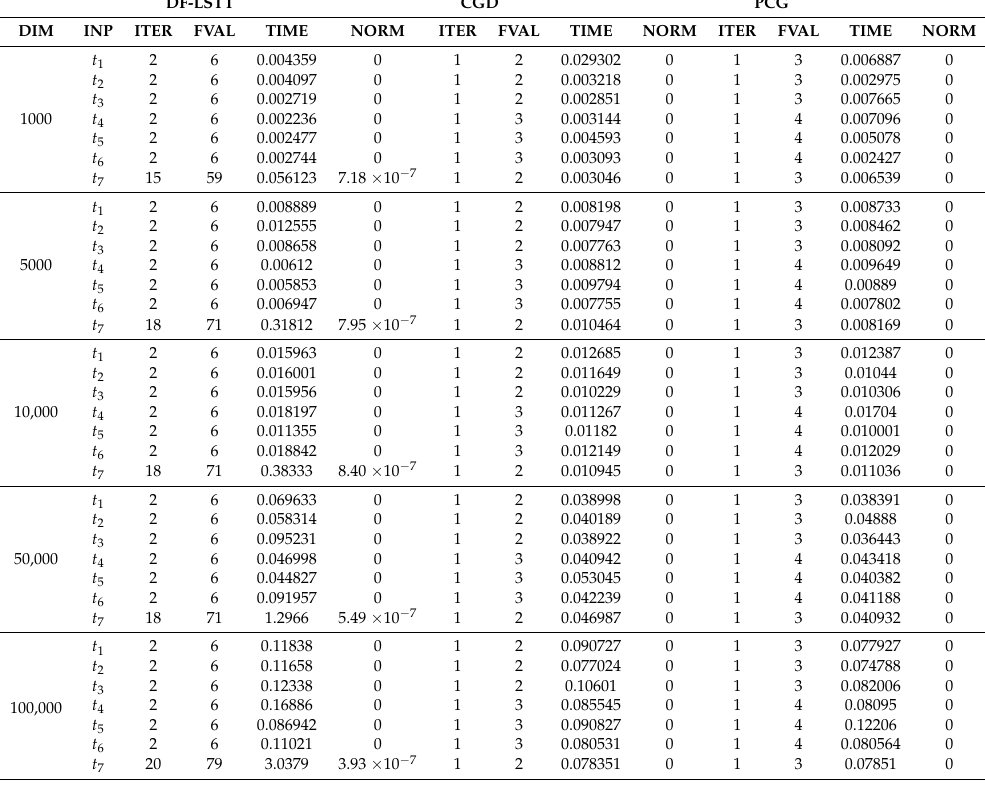
Table 5. Numerical test reports for the three tested methods for Problem